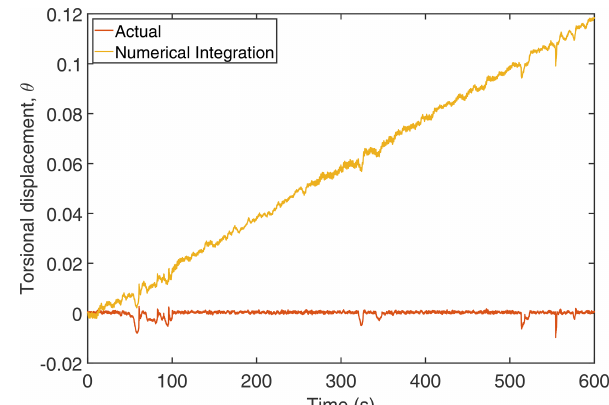
Figure 3. Comparison of time integration displacement with actual displacement. The torsional displacement is in radians.